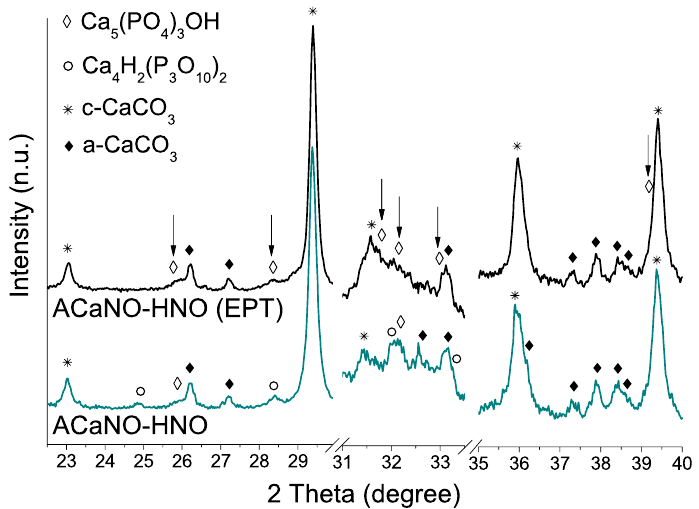
Figure 13. XRD analysis of hydrated BEC surface after 7 days SBF essay: without post-synthesis treatment (ACaNO-HNO), and after EPT (ACaNO-HNO (EPT)).